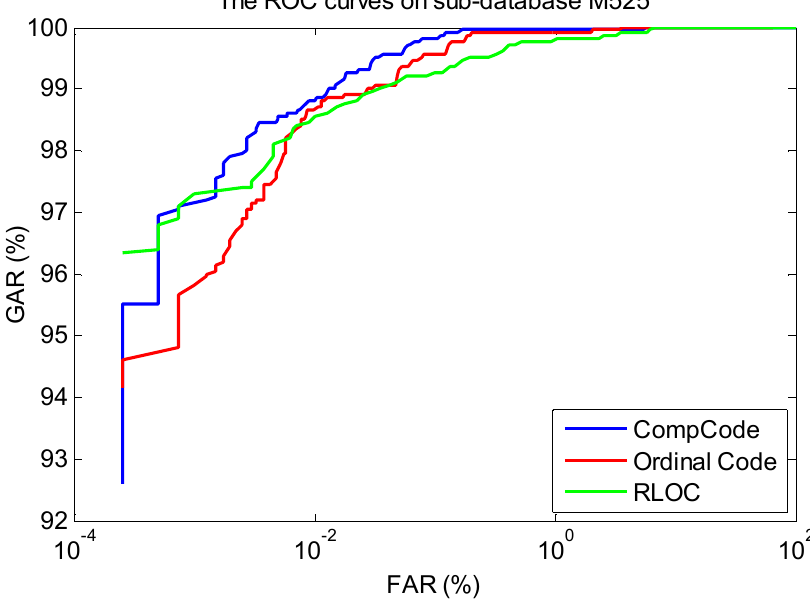
Figure 11. The ROC curves of methods Comp Code, Ordinal Code and RLOC on sub-database M525 (using the 1~3 samples of the first session as the training set).